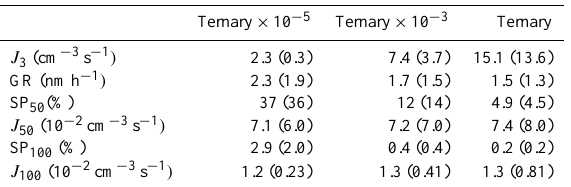
Table 4. Mean and median values for the three ternary simulations at Hyytiälä for the multi-day survival probability calculation. Me- dian values in